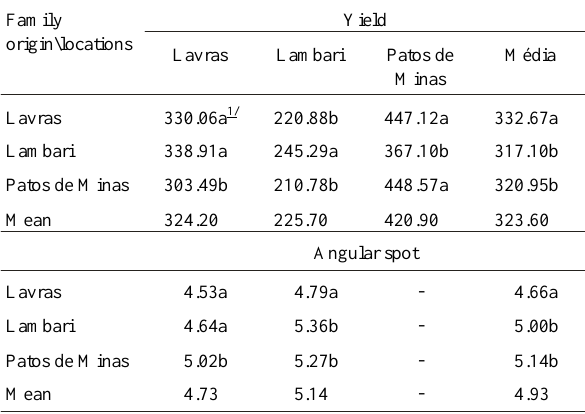
Table II - Mean grain yield (g/plot) of the F 14:16 fam i lies from Lavras, Lambari and Patos de Minas as sessed in the three lo ca tions and an gu lar spot se ver ity scores as sessed only in Lavras and Lambari in the wet sea son 1998/99. Fam ily or i gin\lo ca tions